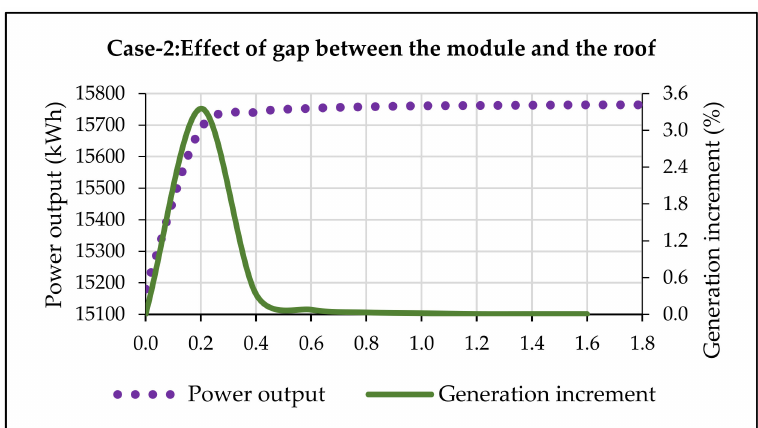
Figure 14. Energy production system for different gaps between the module and roof (tilt angle = 20 ◦ and azimuth angle = 10 ◦ ).